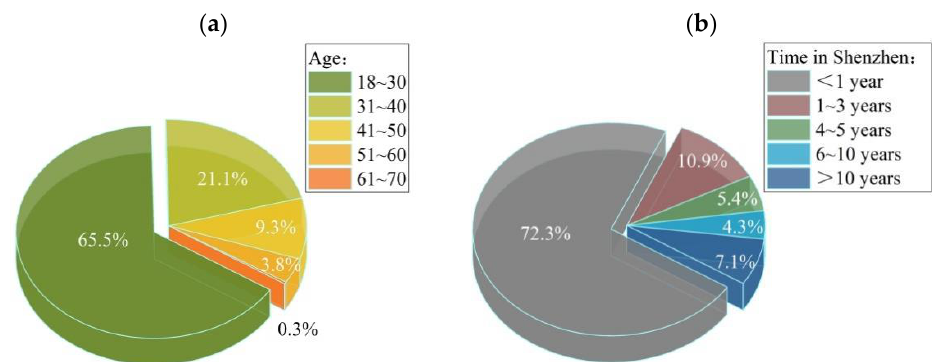
Figure 4. Composition of the interviewees: ( a ) Interviewee age composition; ( b ) Living time of the interviewees in Shenzhen.